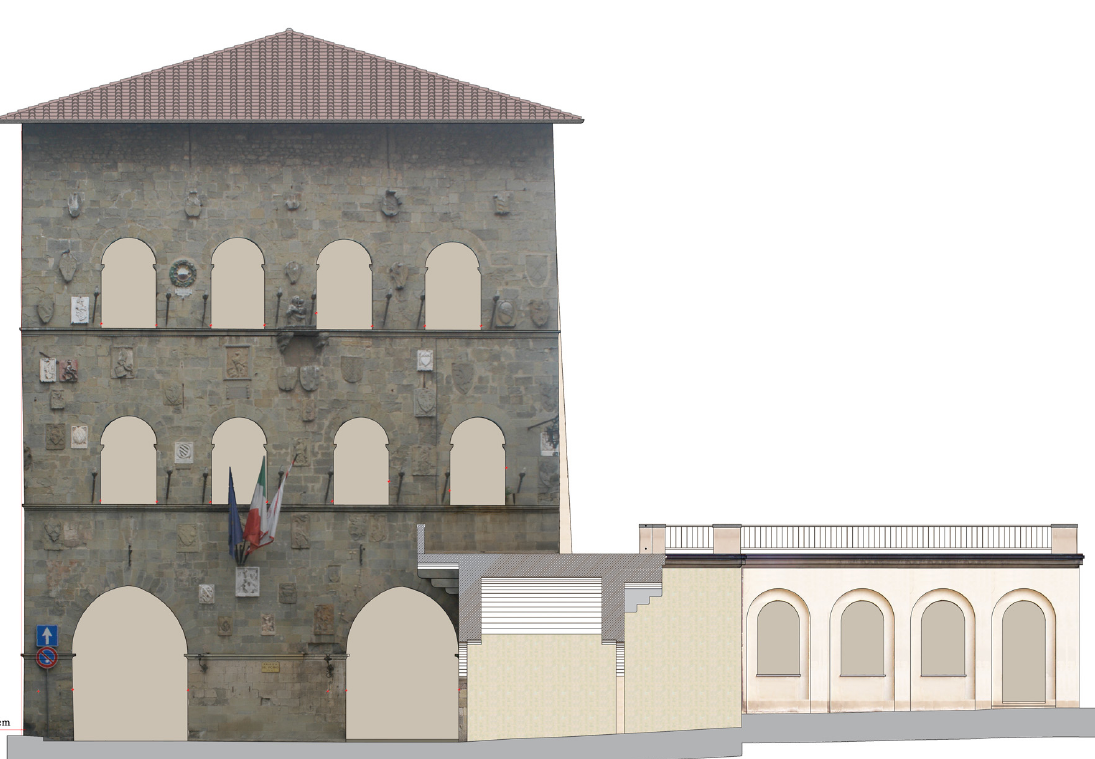
Figure 4. View of the Southern